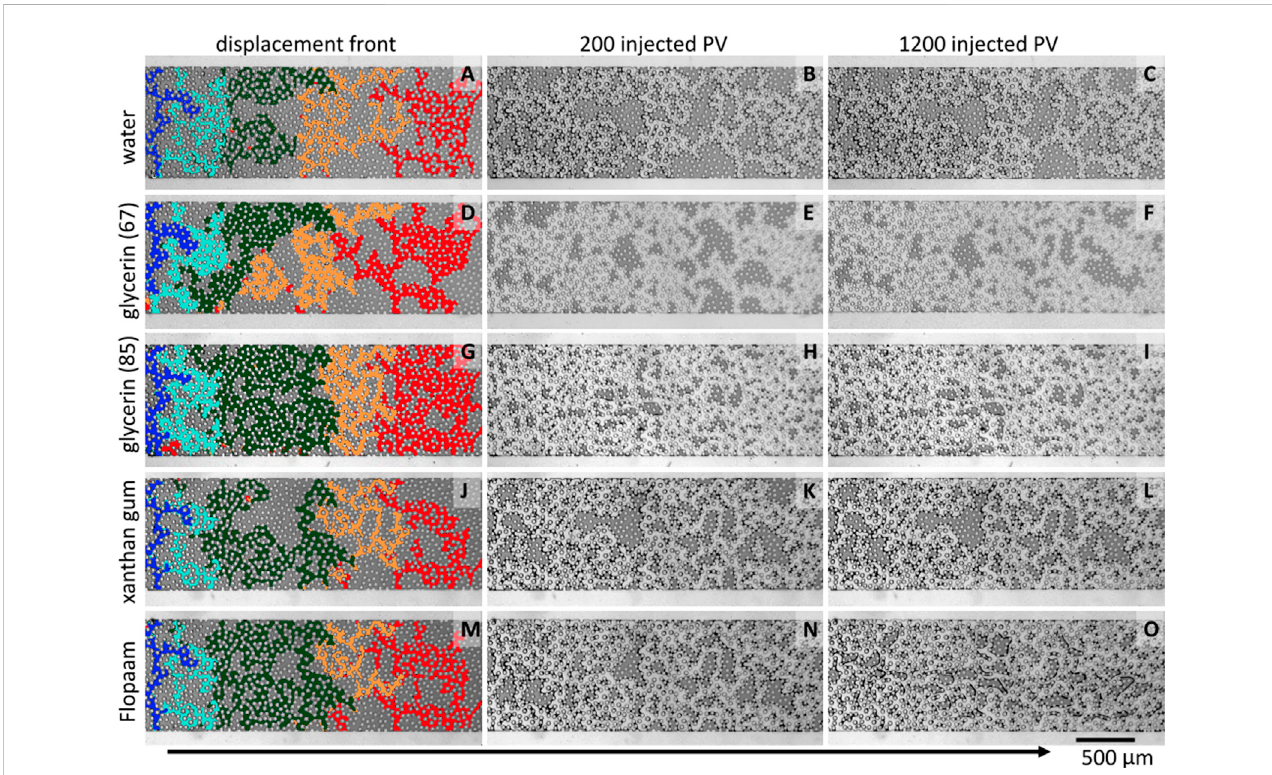
FIGURE 4 Snapshots of the displacement pattern for (A – C) water ( Ca water = 8 · 10 – 6 ), (D – F) 67 w% glycerin ( Ca glycerin ( Ca invading fl uid.Thesecondandthirdcolumnshowdisplacementpatternfor200PV,and1,200PVoftheinvading fl uid.Asindicatedbythearrow,themain fl ow direction was from left to